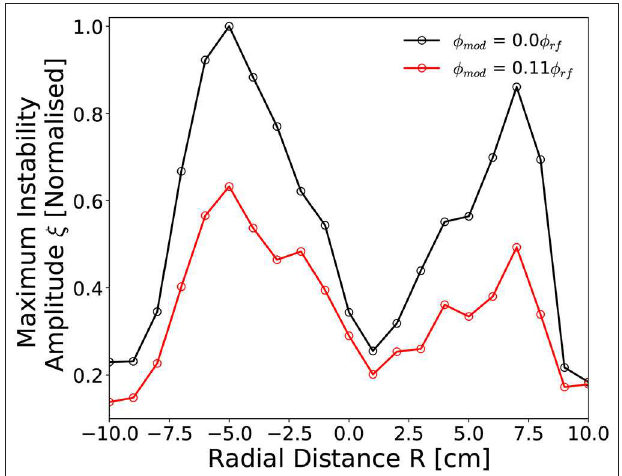
FIGURE 10 | Radially resolved ( − 10 cm ≤ R ≤ 10 cm) instability amplitude downstream of DL ( Z = 2 cm) employing a with a variable 12 kHz voltage amplitude modulation fraction. Solid lines added to guide the eye. Operating conditions: helicon antenna supplied P rf = 300 W at ν rf = 13.56 MHz employing 0.42 mTorr argon with I 1,2 = 6 A solenoid